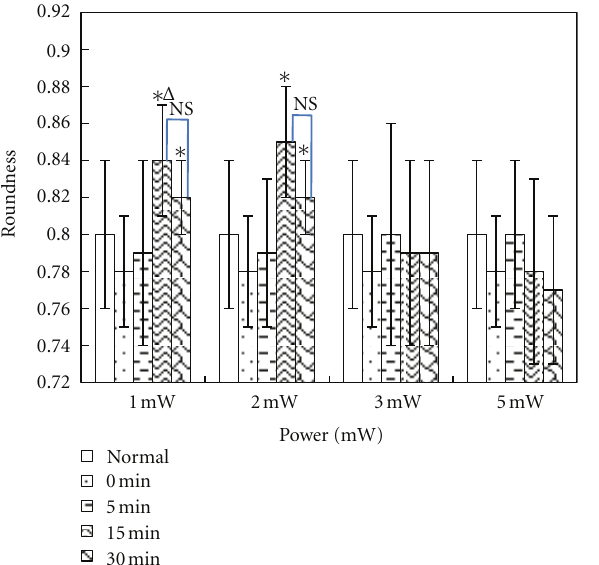
Figure 4: E ff ects of laser irradiation on elongation index of dehydrated erythrocytes. Data are means ± SD. N = 100. ∗ P < 0 . 05 versus the no irradiation group as control.